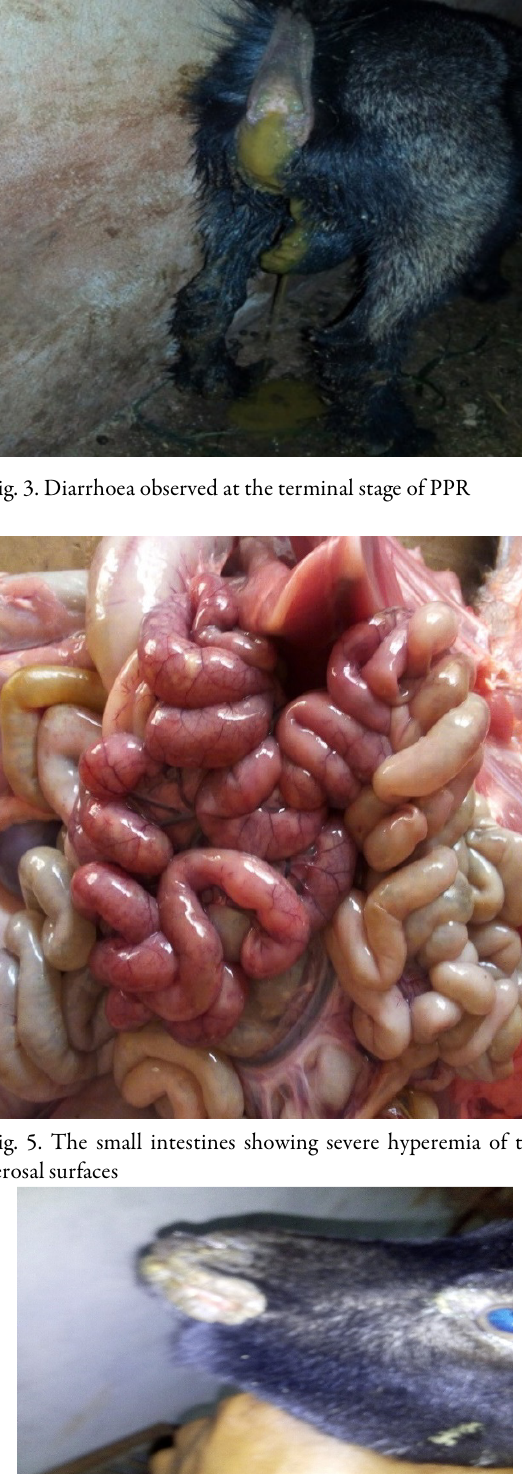
Fig. 8. Interlobular septae thickened by fibrin and cellular infiltrates (arrow). Also, notice the alveoli filled with cellular infiltrates (star). H&E × 100 (Ezeasor,